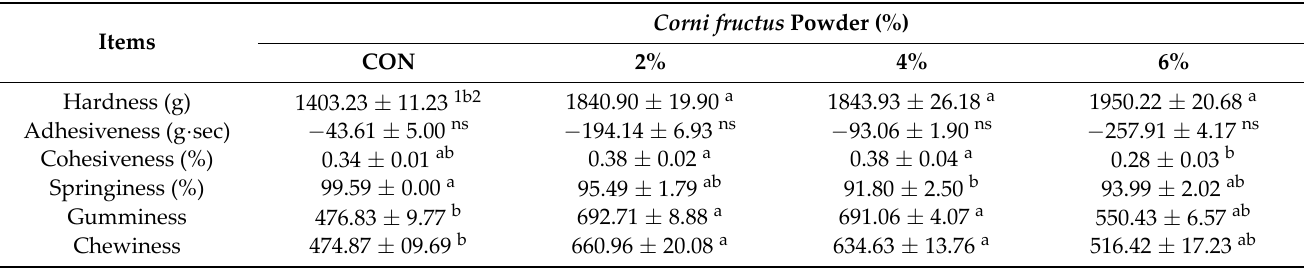
Table 6. The texture of Yanggaeng treated with Corni fructus